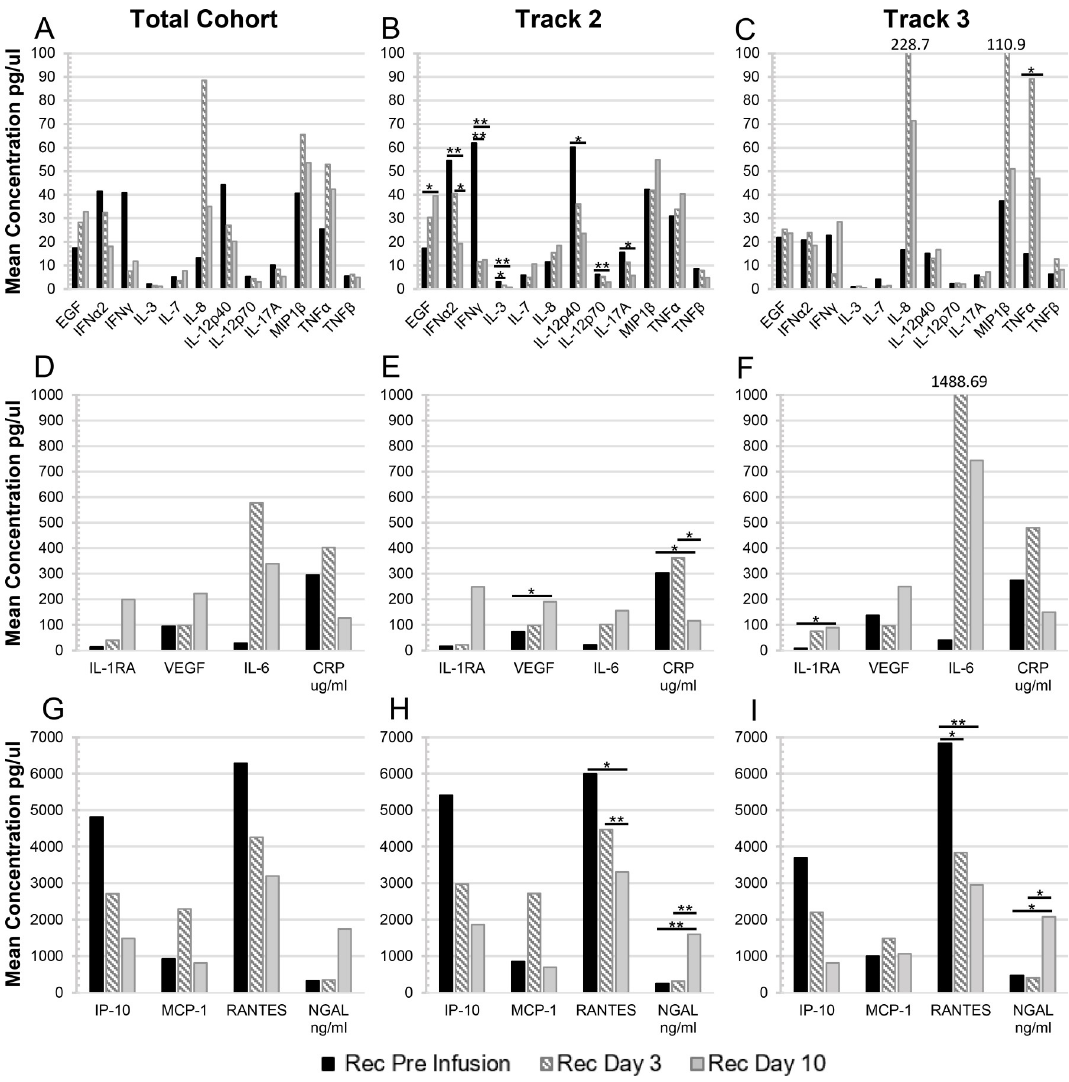
Fig 3. The mean concentrations of elevated cytokines/chemokines in the plasma of CPT recipients over all time points. These figures summarize the mean concentration of 20 cytokines/chemokines that were elevated in at least 20% of the recipients at any of the time points (Fig 2), and grouped based on similar ranges of concentration values: (A-C) 0–100; (D-F) 0–1000; and (G-I) 0–7000 units/ ml. The mean concentration values are also shown separated for: (A, D, G) the total cohort of recipients (Pre-infusion, Day 3, n = 35; or Day 10, n = 32); (B, E, H) recipients in Track 2 (Pre-infusion, Day 3, n = 23; or Day 10, n = 22); or (C, F, I) recipients in Track 3 (Pre-infusion, Day 3, n = 12; or Day 10, n = 10). Statistically significant changes in mean values between time points in the Track 2 and Track 3 cohorts are denoted by ( � ) for 0.01 � p � 0.05 or ( �� ) for p <